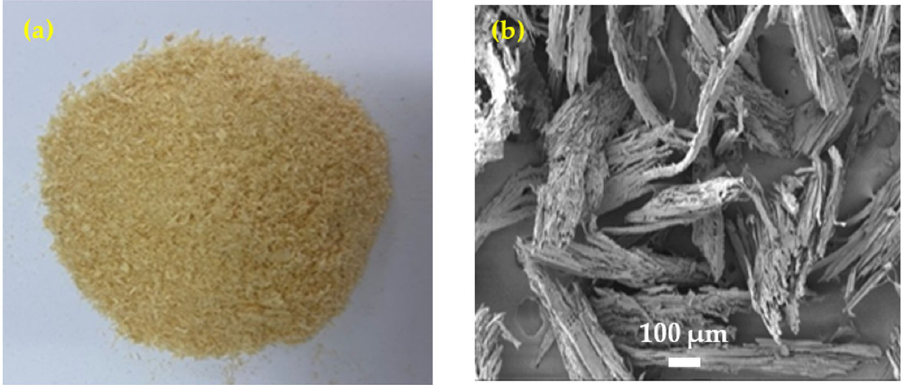
Figure 1. Wood chip morphology: ( a ) appearance of the wood chip; ( b ) SEM image of the wood chip’s microstructure.